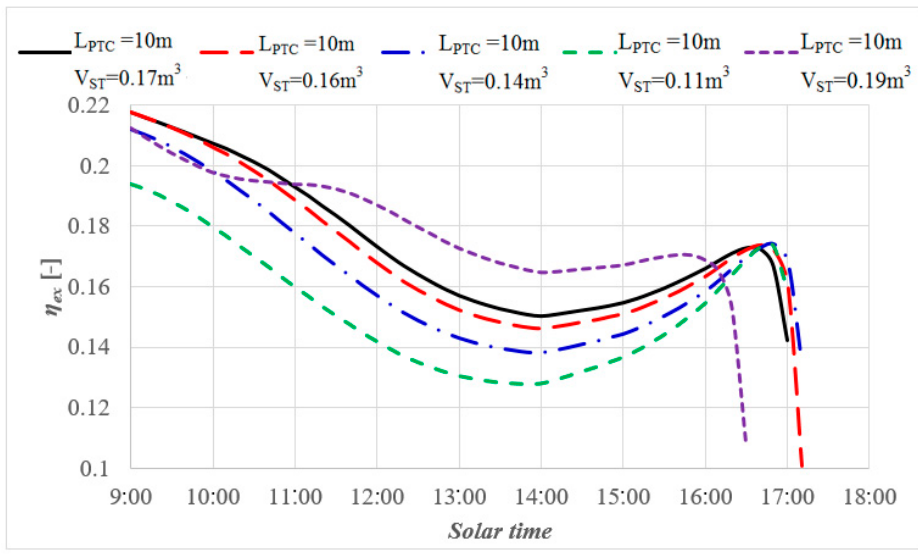
Figure 13. ACS exergetic efficiency—sensitivity with respect to storage tank dimension.